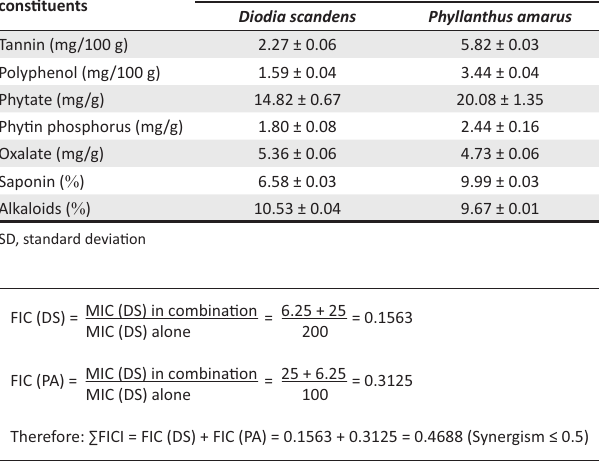
FIGURE 1: Combination studies of D. scandens and P. amarus.